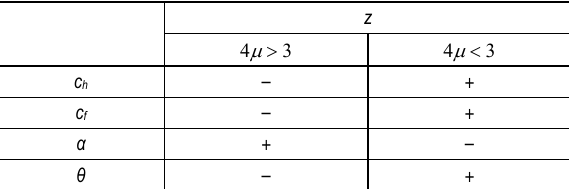
Table 2. Results of comparative